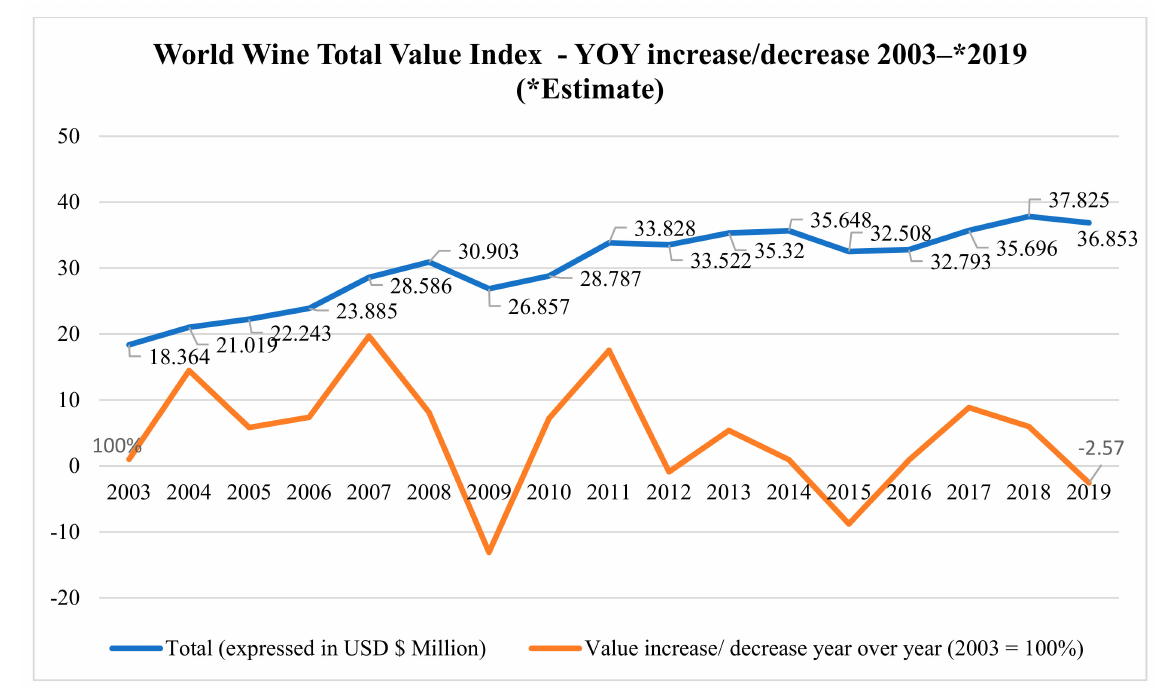
Figure 3. World wine total value index-year-over-year (YOY) increase/decrease. 2003–*2019 (*estimate). Source: Interna- tional Organization of Vine and Wine